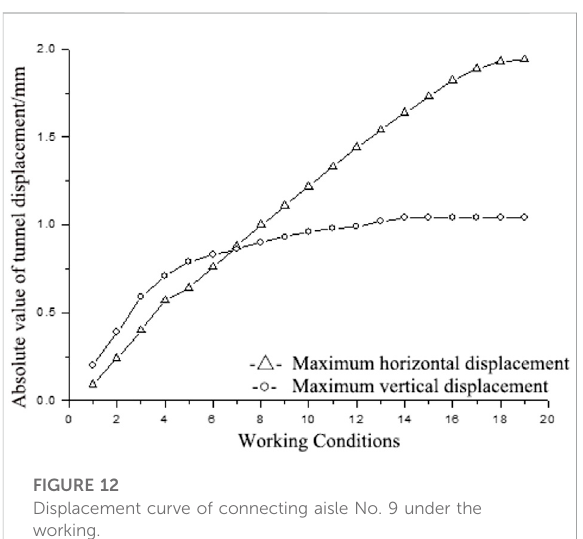
FIGURE 13 Displacement curve of connecting aisle No. 10 under the working